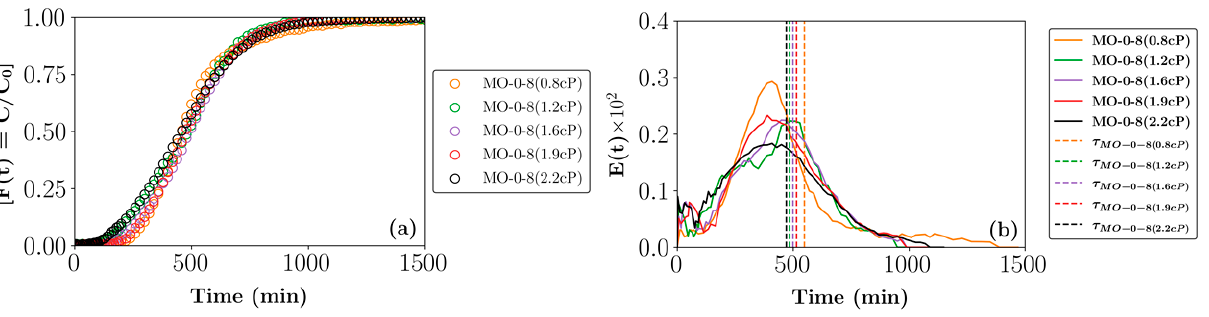
Figure 14. ( a ) Bed voidage, ( b ) total liquid hold-up, ( c ) 24-h drain-down moisture, ( d ) solution break- through time characterisation data for beds composed of 0-8 mm MO particles and irrigated with different viscosity solutions (0.8. 1.2, 1.6, 1.9, and 2.2 cP).